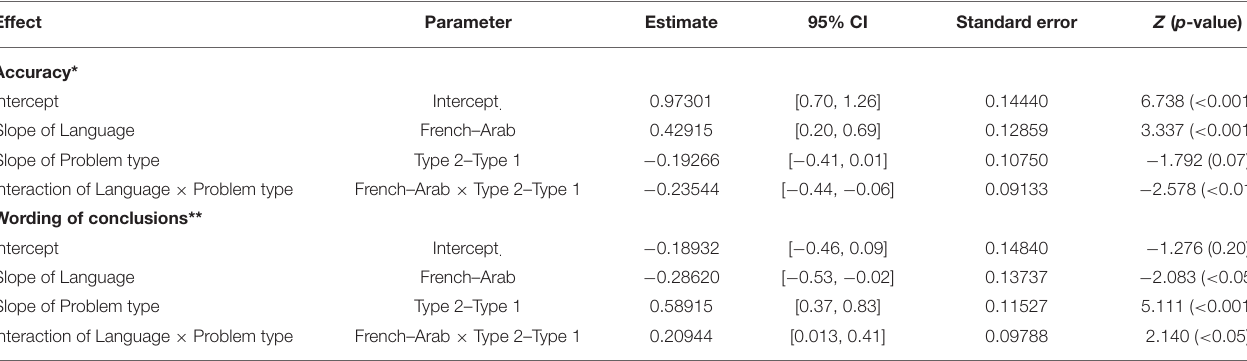
TABLE 3 | Parameter estimates of models Accuracy and Wording of